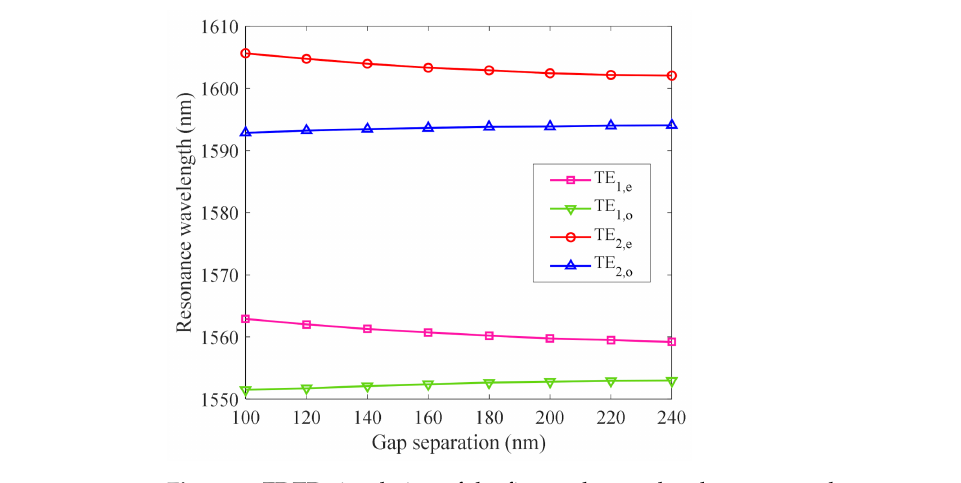
Figure 2. FDTD simulation of the first and second-order supermode resonance wavelength tuning versus the coupling